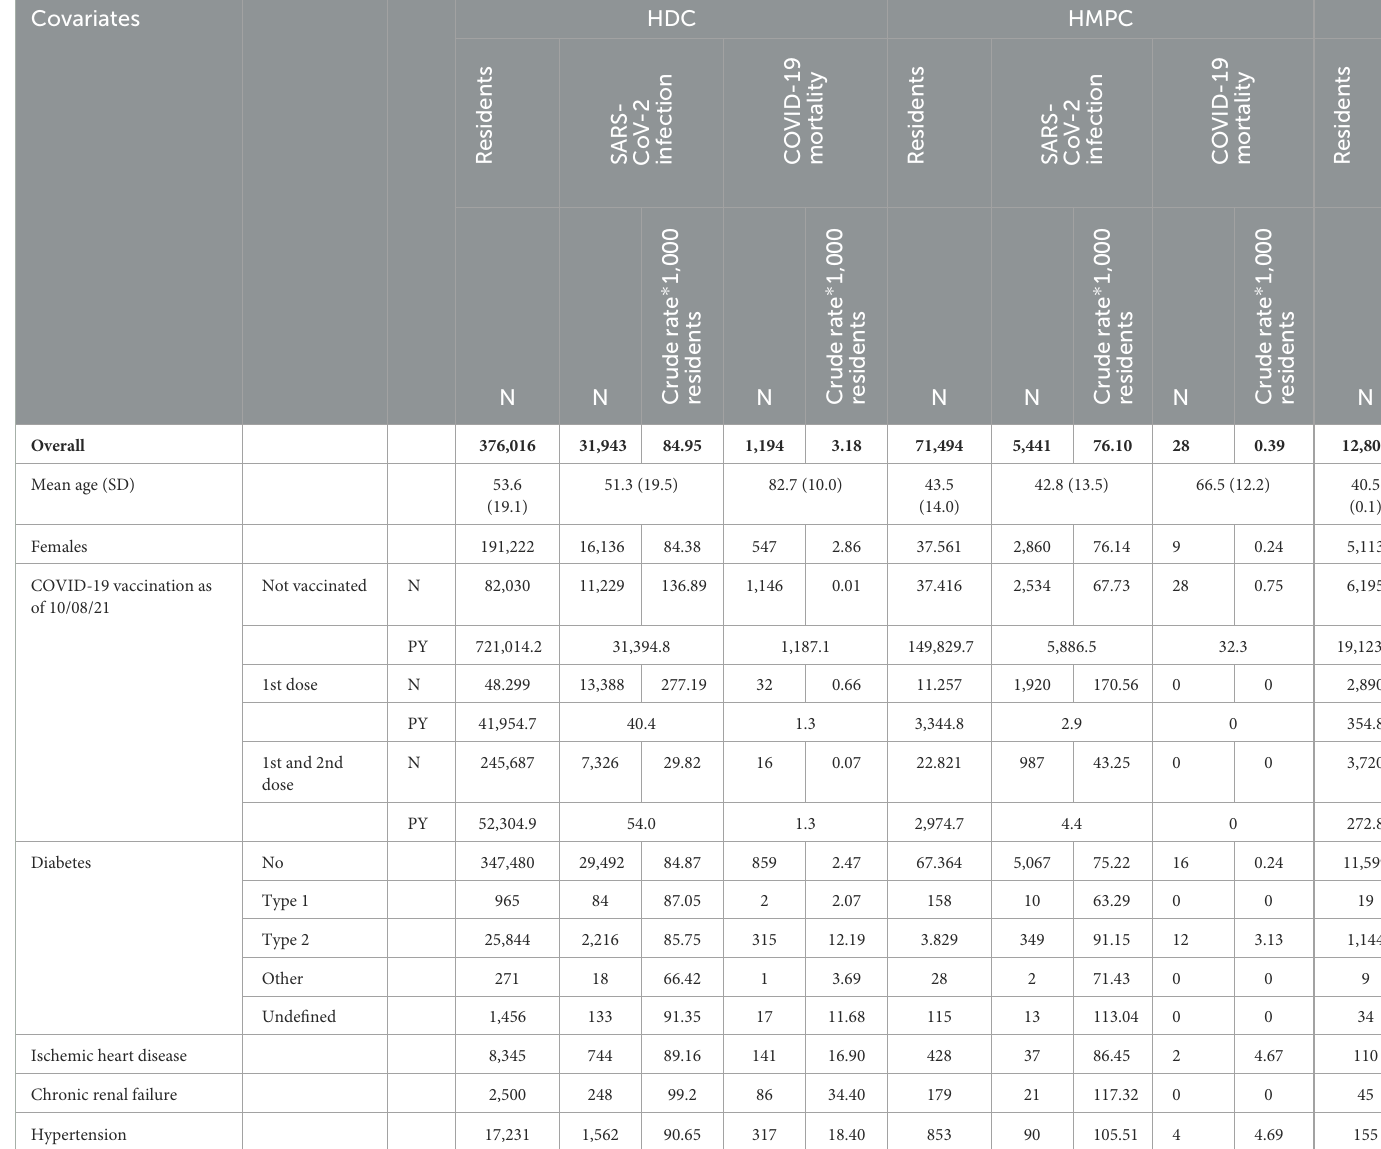
TABLE 1 Resident population in the province of Reggio Emilia, number of first SARS-CoV-2 infections and deaths from COVID-19, by demographic and clinical characteristics.